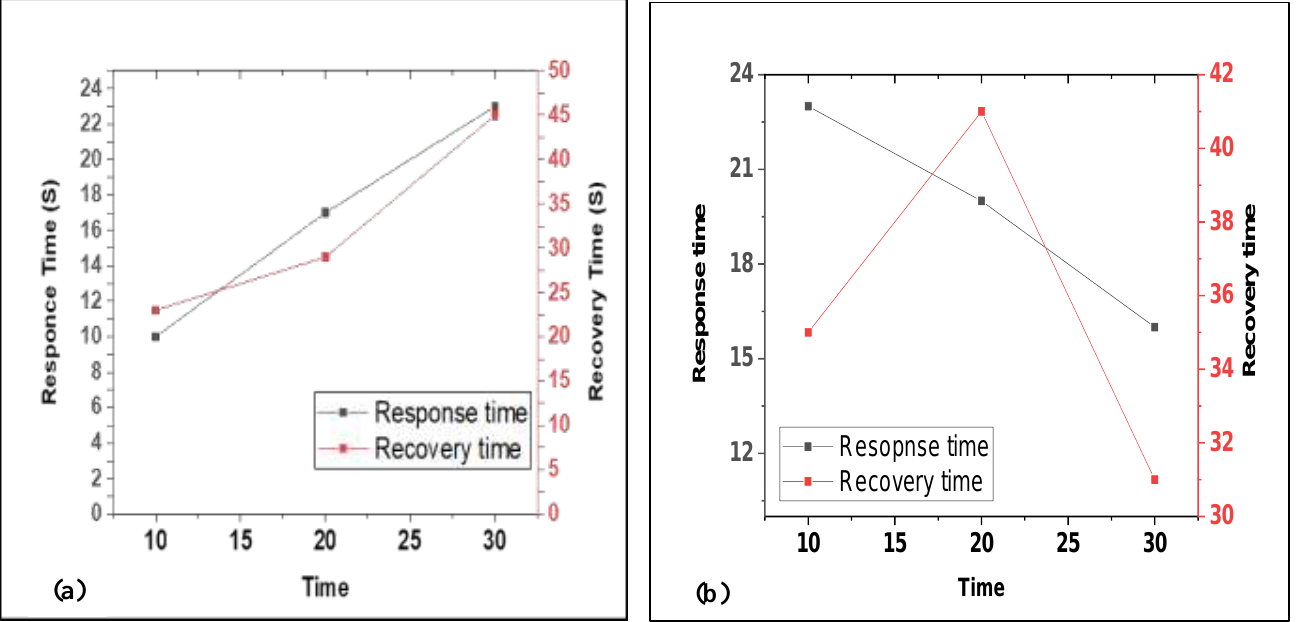
Figure 7: Response and recovery time versus start time for (a) ethanol (b)